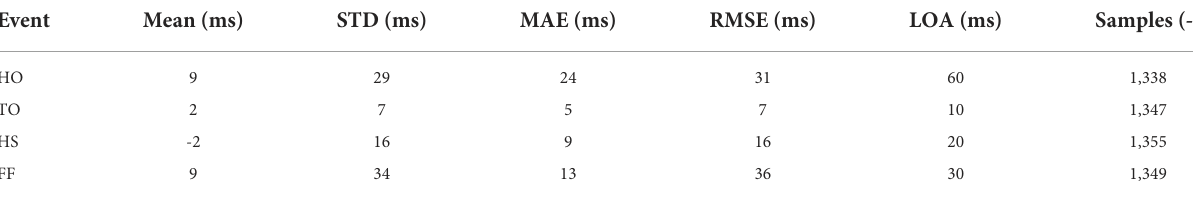
TABLE 2 Error metrics for WGAS gait event detection results.